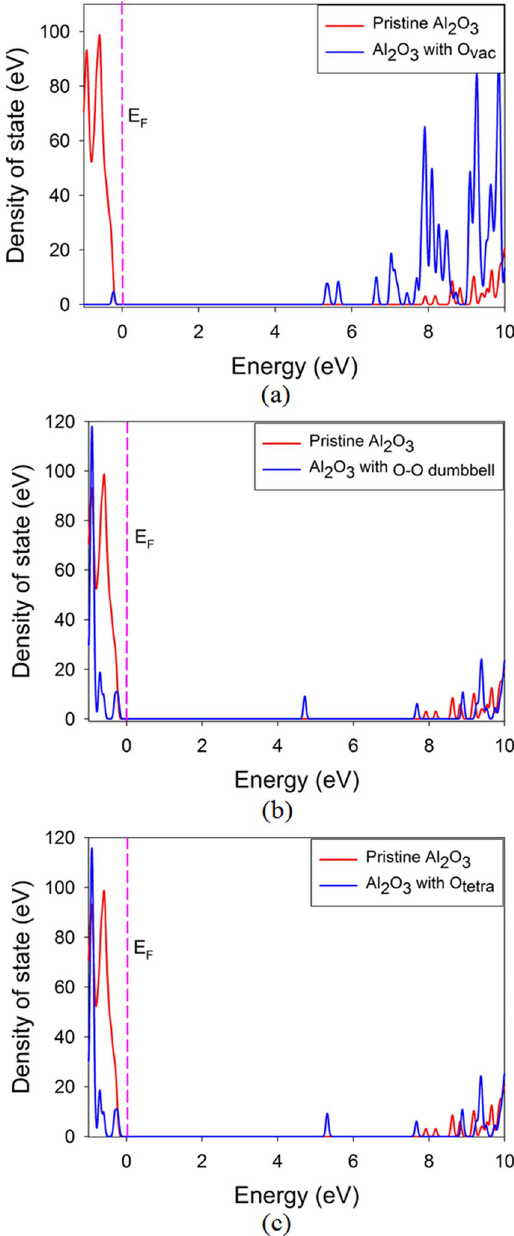
Figure 5. Total density of state distribution for α -Al 2 O 3 with ( a ) oxygen vacancy; ( b ) oxygen dumbbell pair; ( c ) oxygen interstitial occupying the tetrahedral site. E F indicates the Fermi level and is set to be